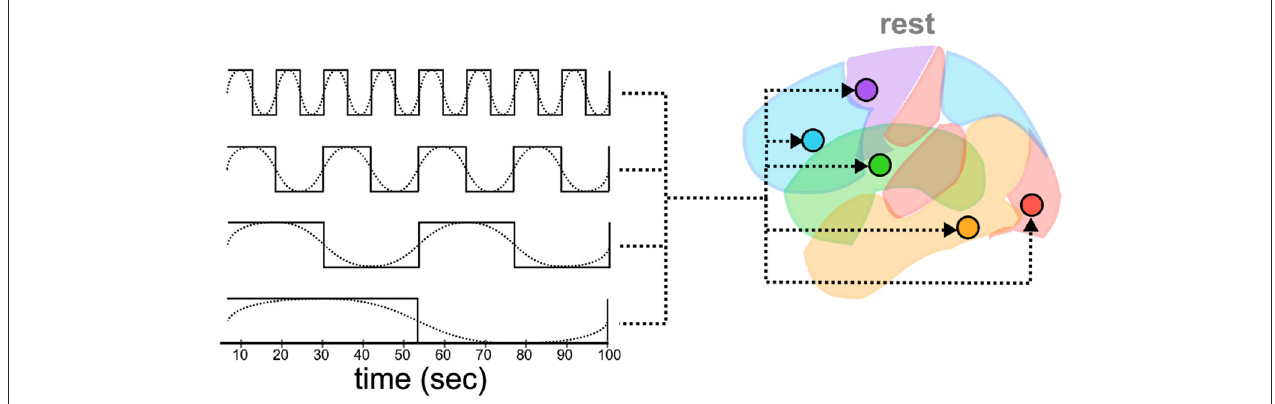
FIGURE 3 | Oscillatory waves of different frequencies (dotted lines) are and phases (not shown) translated into binarized “box-car” plots of events (solid lines). Each event is then simulated as a driver of activity in all